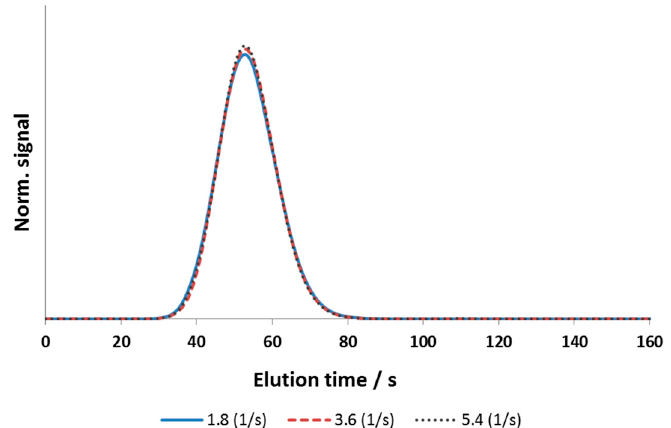
Figure 5. Influence of the rate coefficient k eff,A on the peak shape of a simulated acetone tracer signal. Flow rate: 3 mL/min.